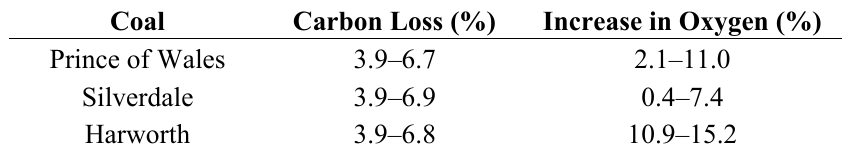
Table 2. Effect of air pressure on carbon and